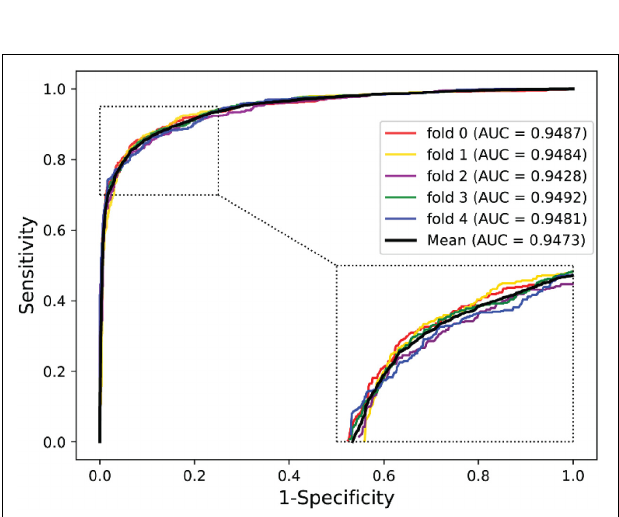
FIGURE 9 | ROC curves performed by the proposed model on human